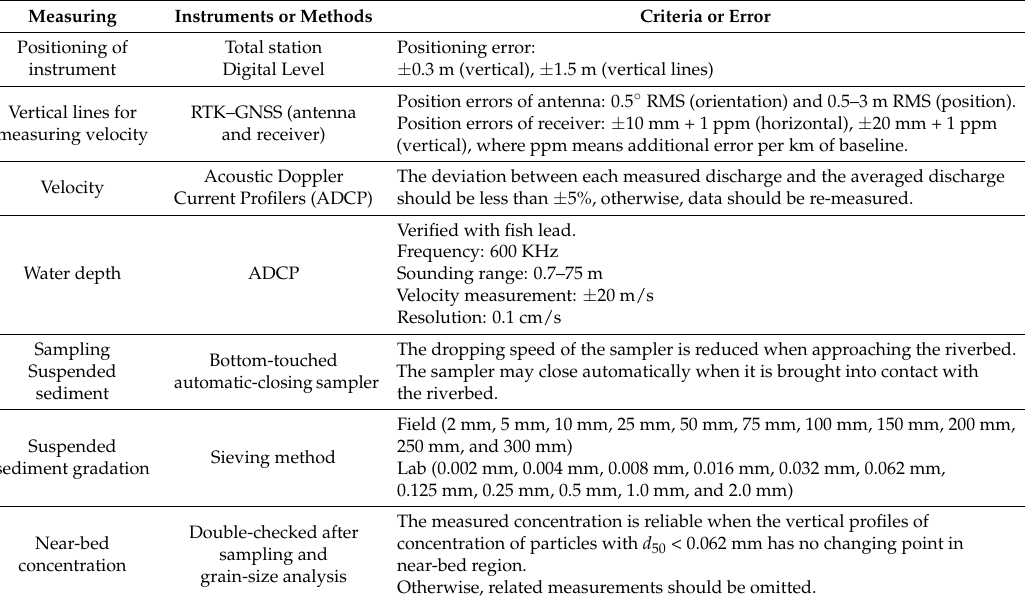
Table 8. Instruments, methods and criteria adopted in the field